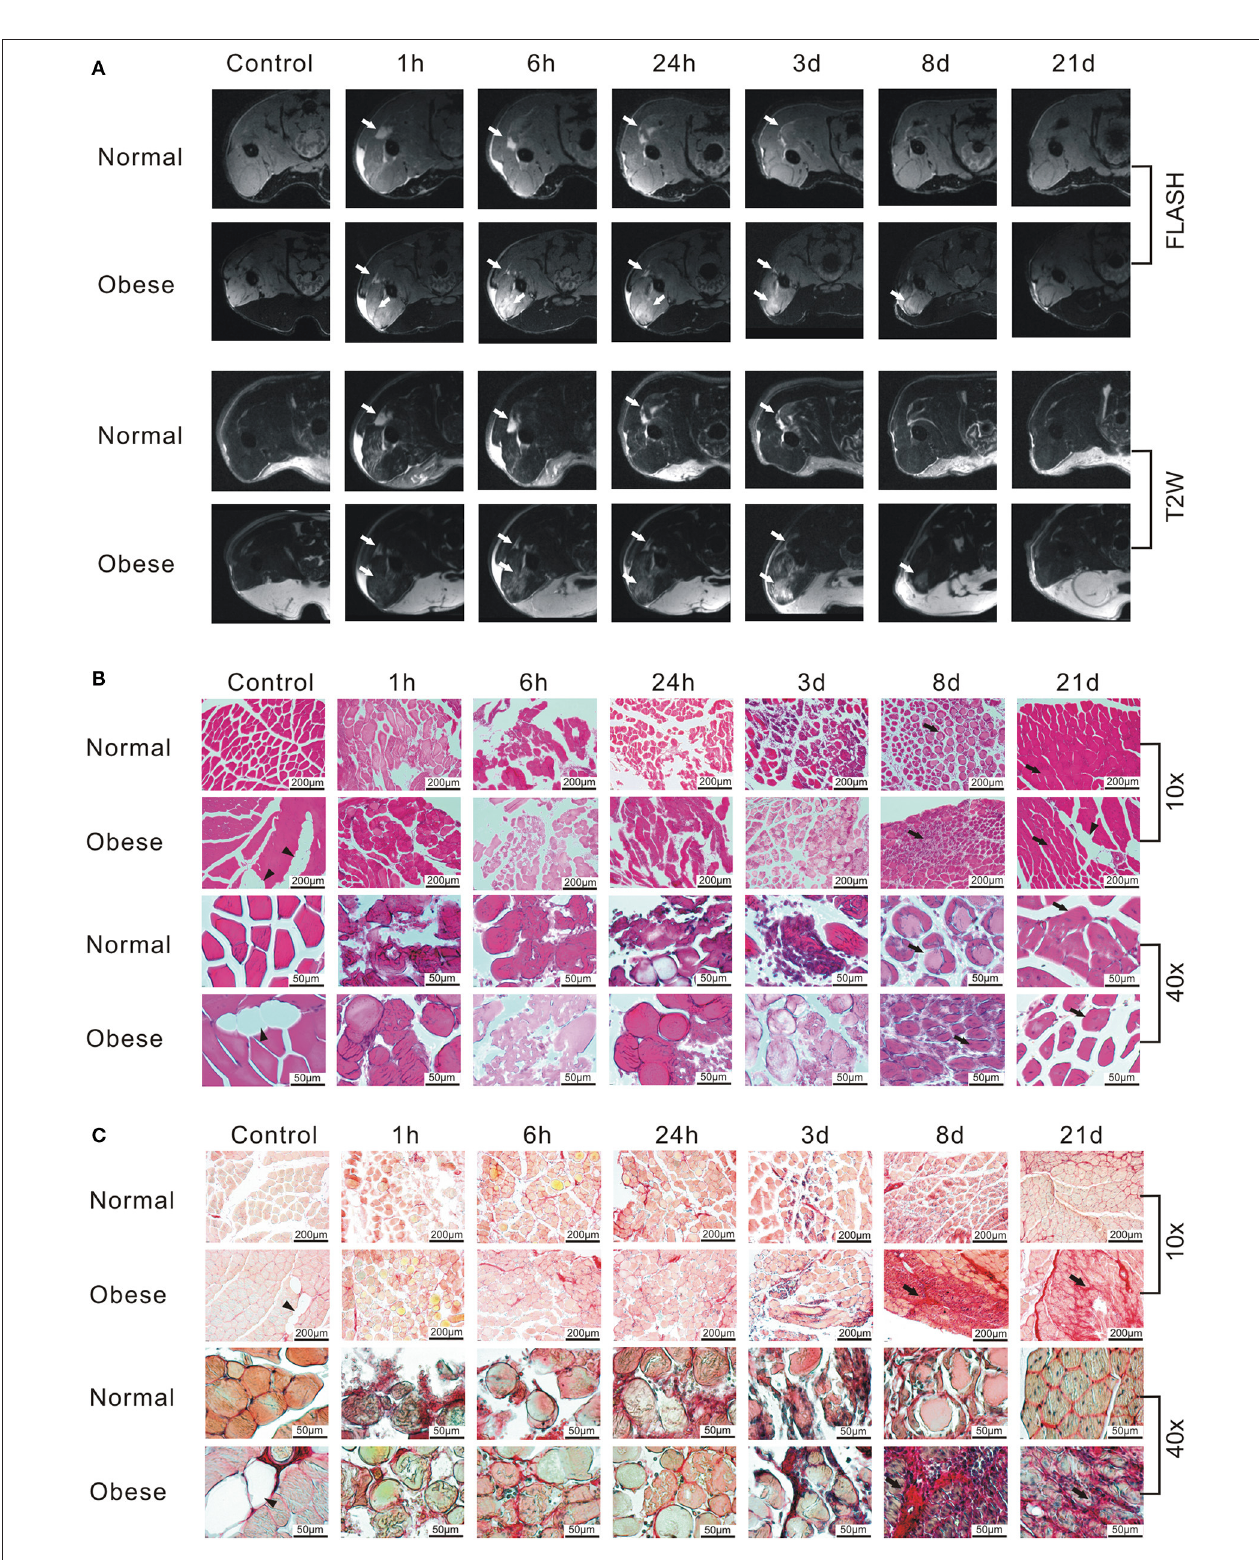
FIGURE 3 | Monitoring of the regeneration process after induction of a blunt muscle injury in female normal weight and obese C57BL/6J mice. (A) FLASH and T2W-RARE recordings of two female C57BL/6J mice receiving either ND or HFD. Arrow = edema. Same animals were used for the whole time course.